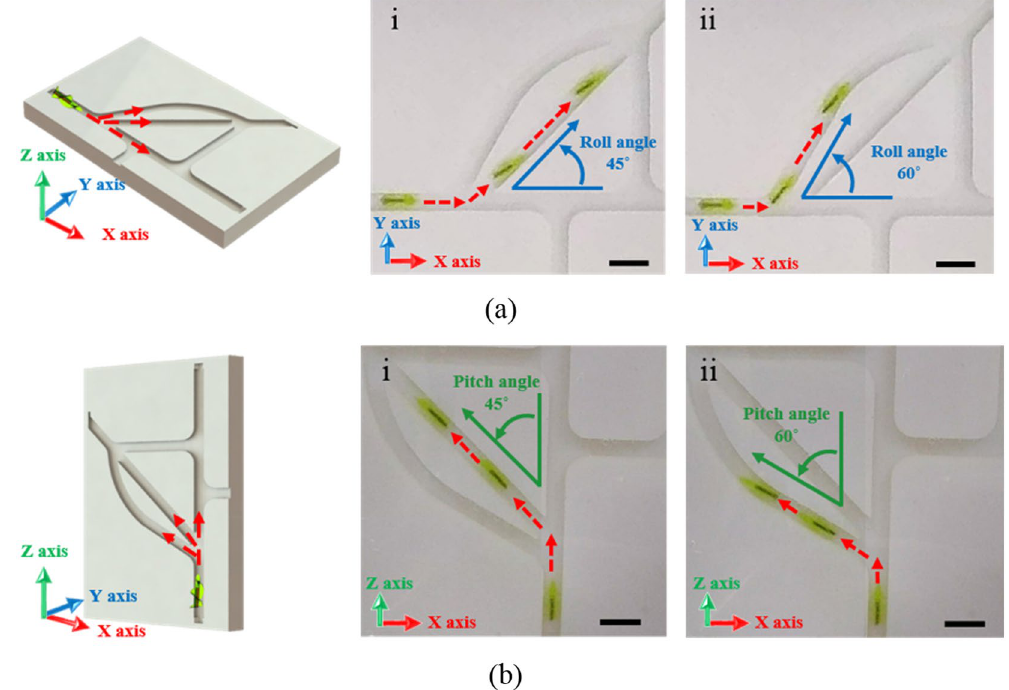
Figure 3. Manipulation of the MDA in 2D vascular network model. Translational locomotion of the MDA with double spirals in the 2D vascular network model placed: ( a ) on the horizontal plane and ( b ) on the vertical plane. (i) and (ii) show selective movement of the MDA toward 45° and 60° channels, respectively, by manipulation using EMA. Scale bar represents 10 mm. The MDA selected and moved along the desired path via the junctions of multiple channels with different angles.